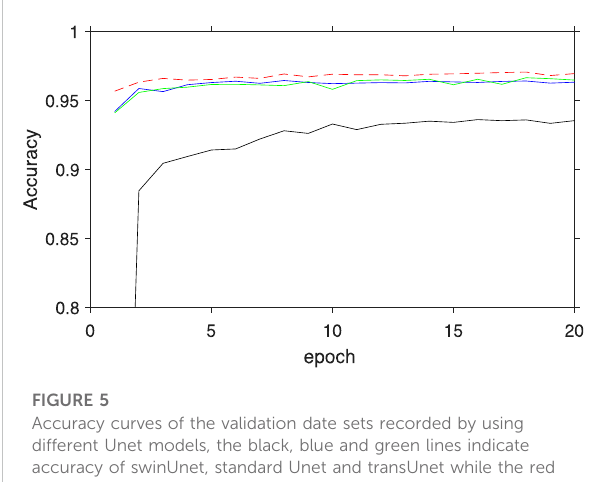
Accuracy curves of the validation date sets recorded by using different Unet models, the black, blue and green lines indicate accuracy of swinUnet, standard Unet and transUnet while the red dashed line is the accuracy of our proposed dual Unet with transformer.